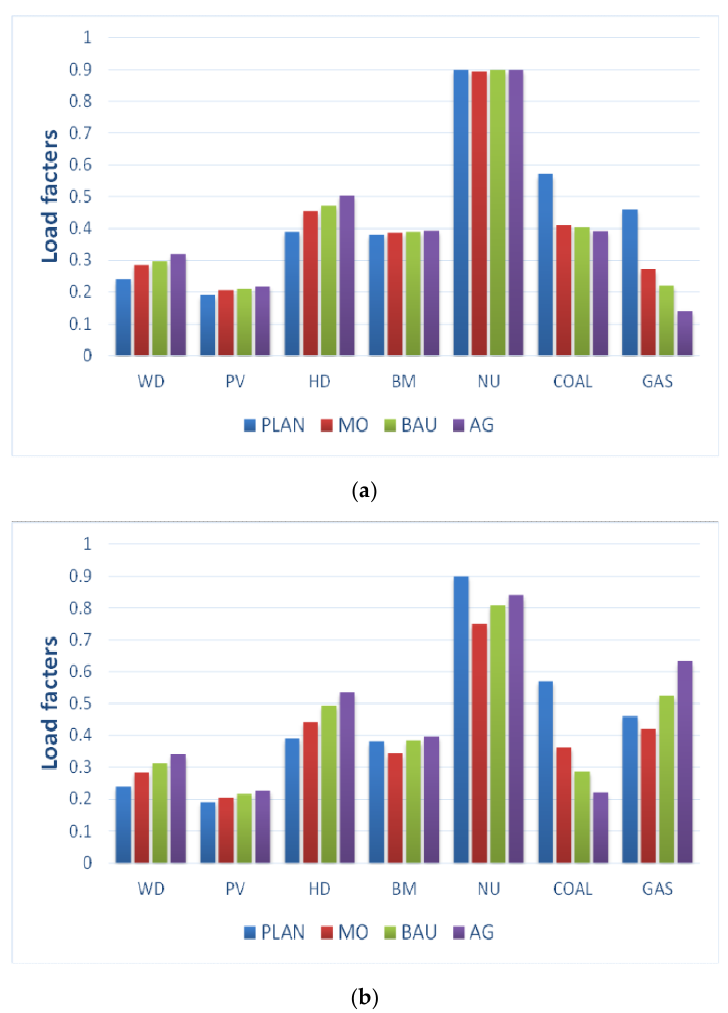
Figure 6. Load factors for the technologies in the total electricity power industry under the planned power generation and the three electricity marketization policies (MO, BAU and AG). ( a ) Load factors in 2025; ( b ) Load factors in 2035.